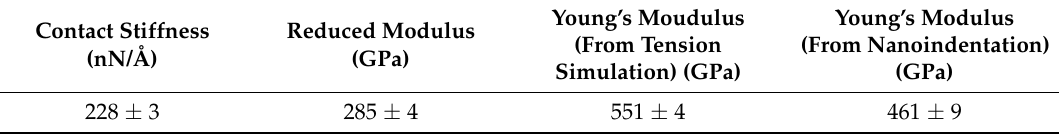
Table 2. Hardness and Young’s modulus calculated from nanoindentation. Comparison between Young’s moduli from tension test and